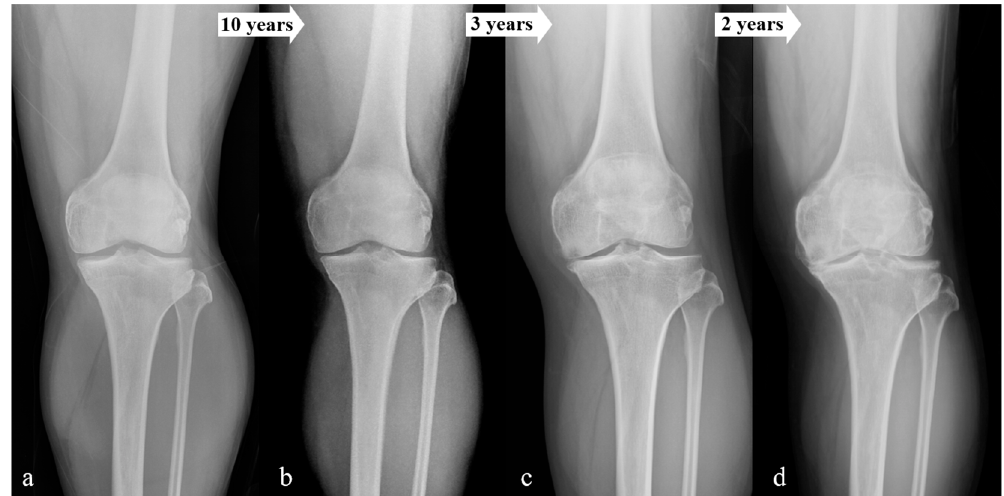
Figure 3. Serial changes of K–L grade, ( a ) initial anteroposterior (AP) X-ray (K–L grade 0-1); ( b ) 10 years later (K–L grade 2); ( c ) 13 years later (K–L grade 3); and ( d ) 15 years later (K–L grade 4).